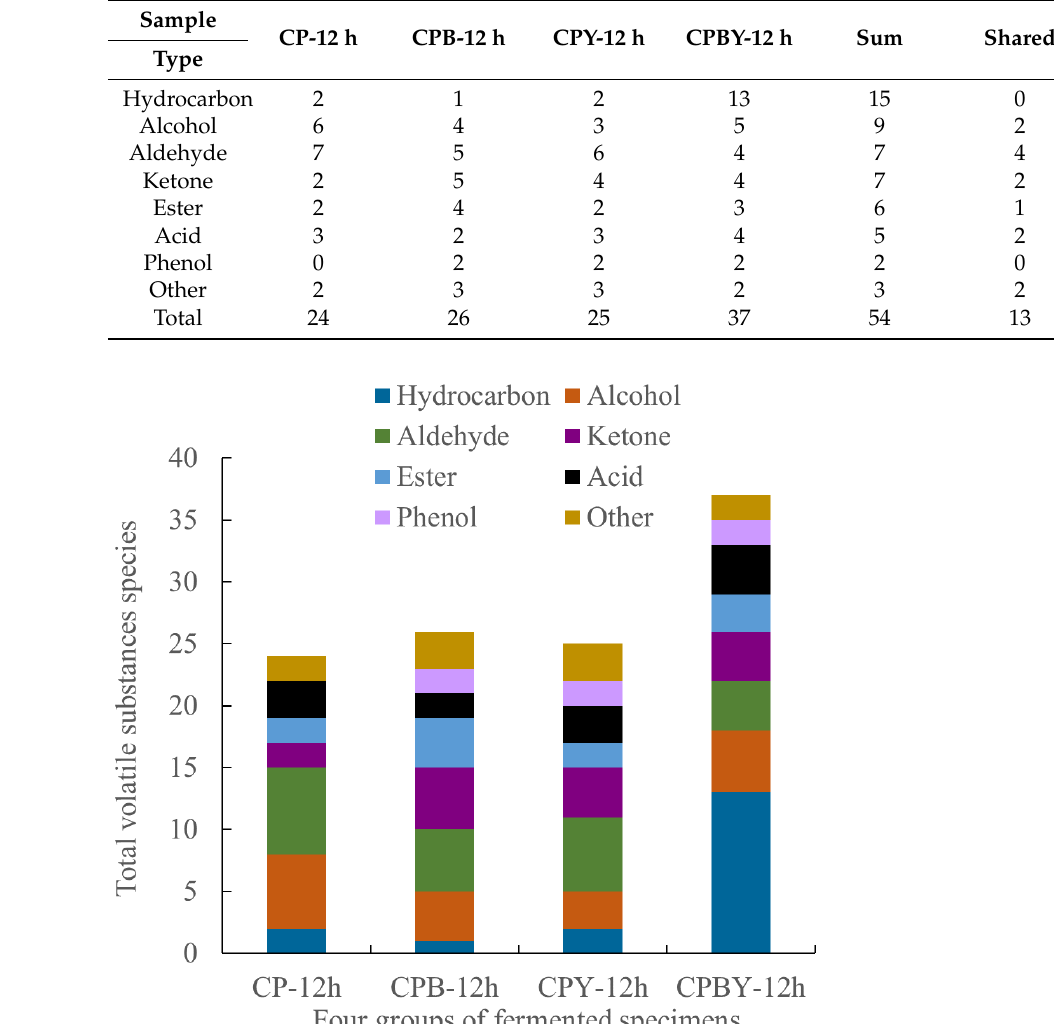
Table 5. Types of volatile odor substances in four groups of fermented specimens.